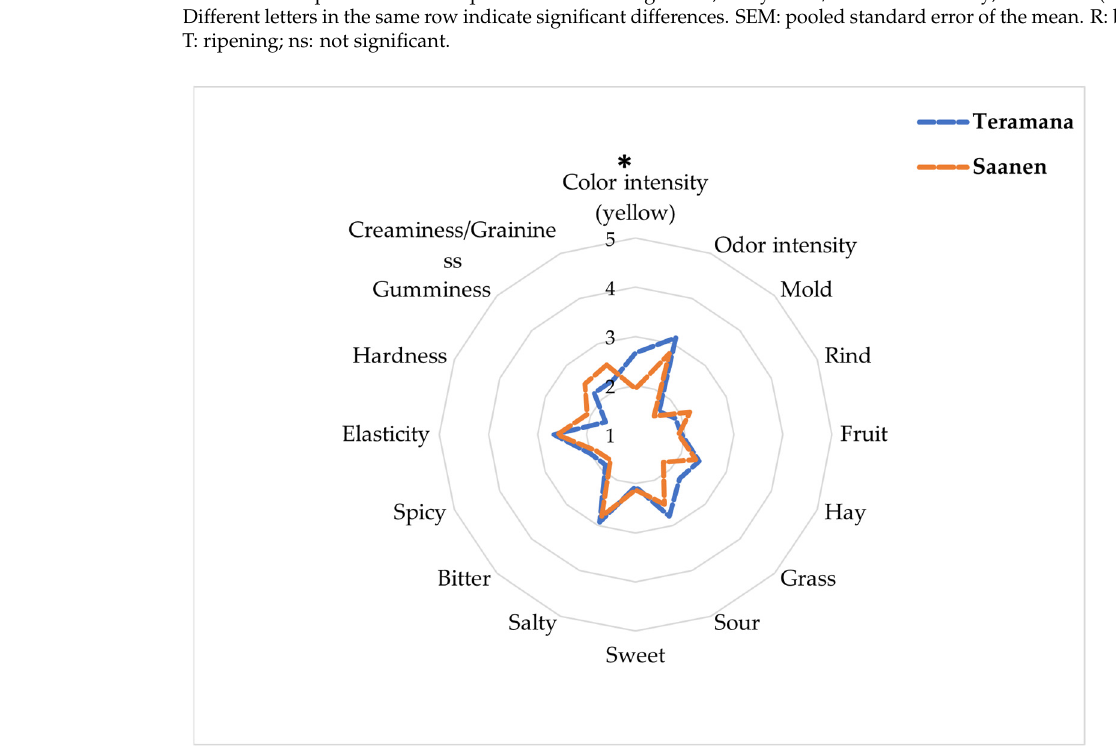
Table 5. Physical properties of cheese at 0 (T0), 30 (T30), and 60 (T60) days of ripening, obtained from the milk of goat breeds: Teramana and Saanen.